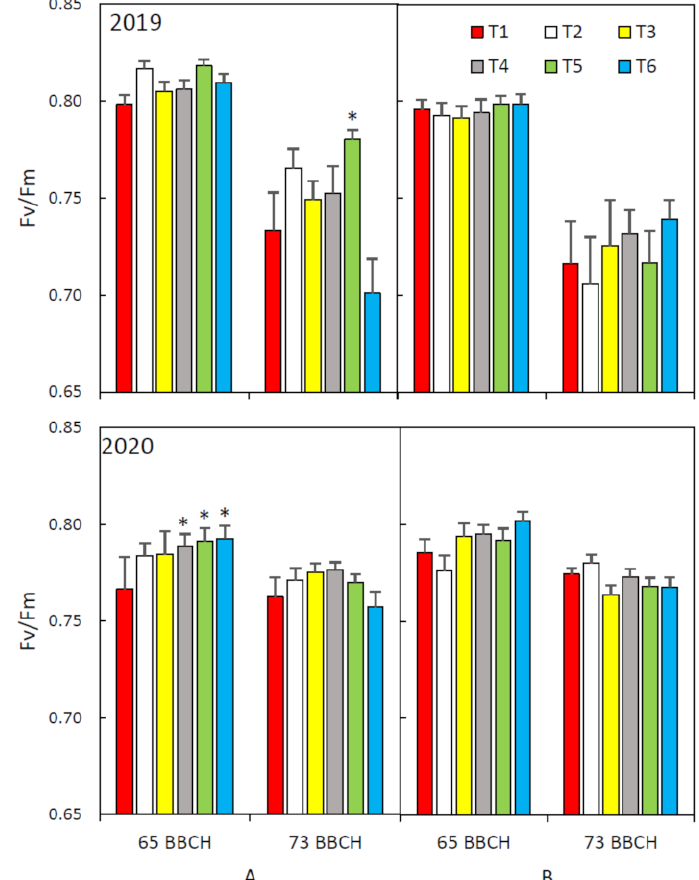
Figure 3. The maximum quantum yield of PS II (Fv/Fm) in the cultivar with blue aleurone KM-72- 18 ( A ) and a multi-row spike KM-94-18 ( B ) in the development phases 65 and 73 BBCH at single treatments of the stand (T1–T6). Means ± SE; n = 5; LSD post hoc test. For each period and cultivars, the columns with the symbol * are significantly different at p < 0.05 compared to the control treatment